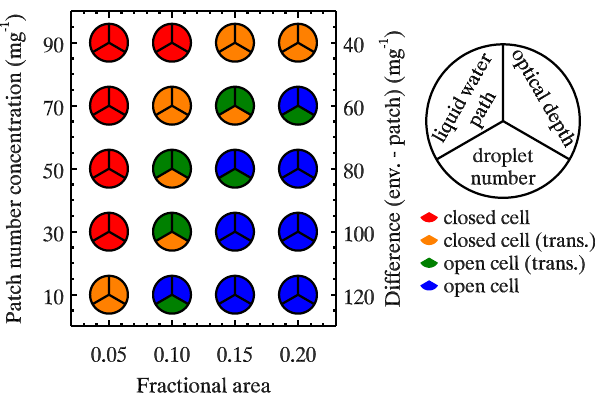
Figure 7. Metric for the open-cell transition for all S2 cases at 12h. In the diagram, each circle represents one case, and each part of the circle indicates either LWP, N d or τ , and is colored according to the classified